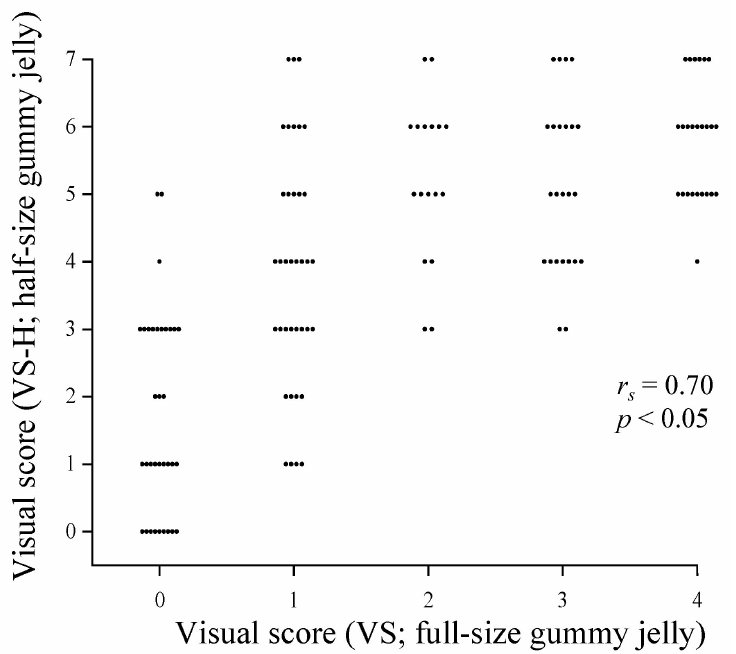
Figure 3. Relationship between masticatory performances determined using the two types of gummy jelly. The cluster of dots indicates the number of participants. The visual score showed a positive cor- relation between the test with half-size gummy jelly and that with full-size gummy jelly. Spearman’s ranked correlation coefficient ( p <